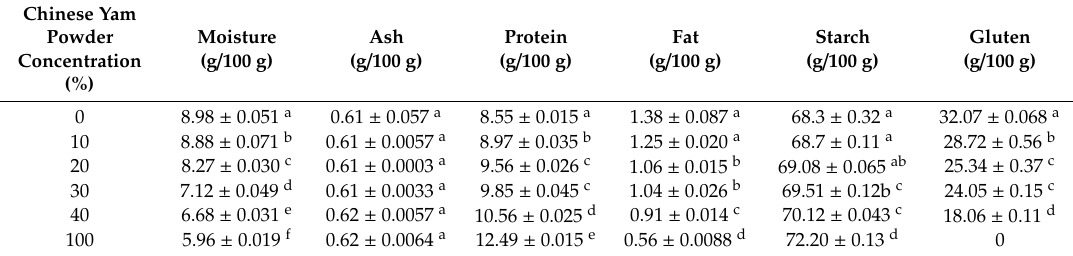
Table 1. Chemical composition of wheat flour–yam powder